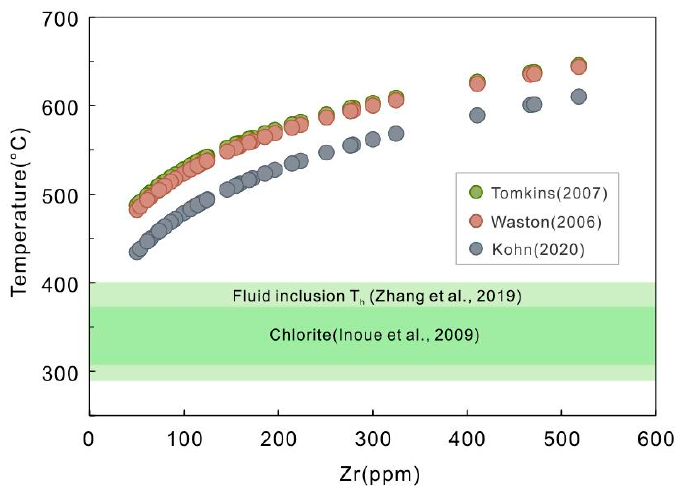
Figure 7. Plot of Zr content variation and corresponding temperature ( ◦ C) based on Zr-in-rutile thermometers of [14,15,54]. For comparison, the homogenization temperatures estimated from quartz-hosted fluid inclusions [23] and temperatures yielded by chlorite thermometry are shown